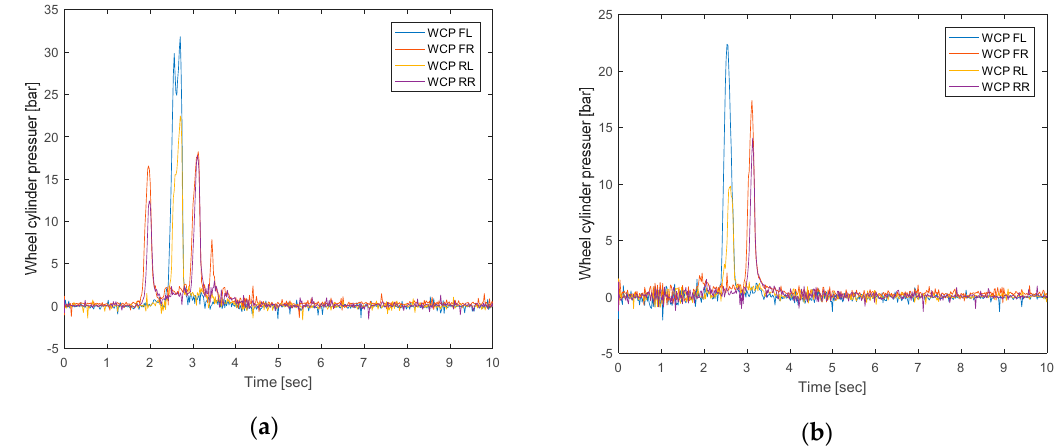
Figure 23. Based on the observation of tire force, the brake wheel cylinder pressure value under the test condition of the maximum steering angle. ( a , b ) are the brake wheel cylinder pressure values of the vehicle model using tire force observation when the maximum steering angle of the test conditions is 270 deg and the road adhesion coefficient is 0.5 and 0.8 respectively.